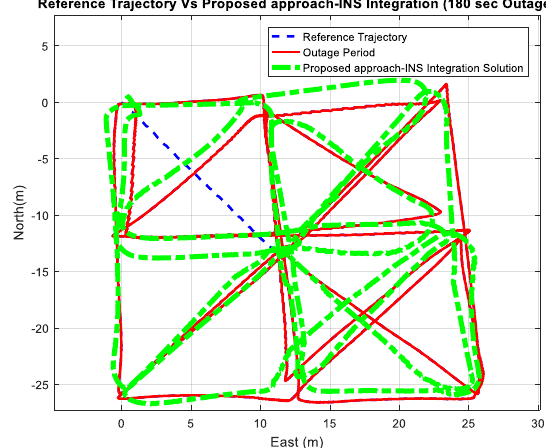
Figure 19. Performance of the proposed approach (camera and UWB) integrated with INS, with lower UWB system infrastructure for a complete 3-minute GNSS signal outage (configuration e )